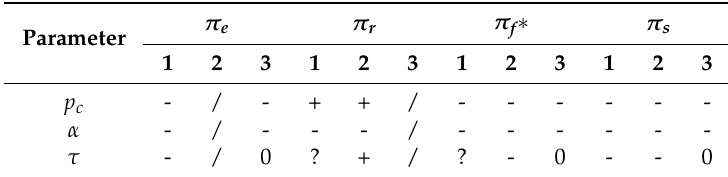
Table 4. The impacts of different parameters on the profits. π e π Parameter